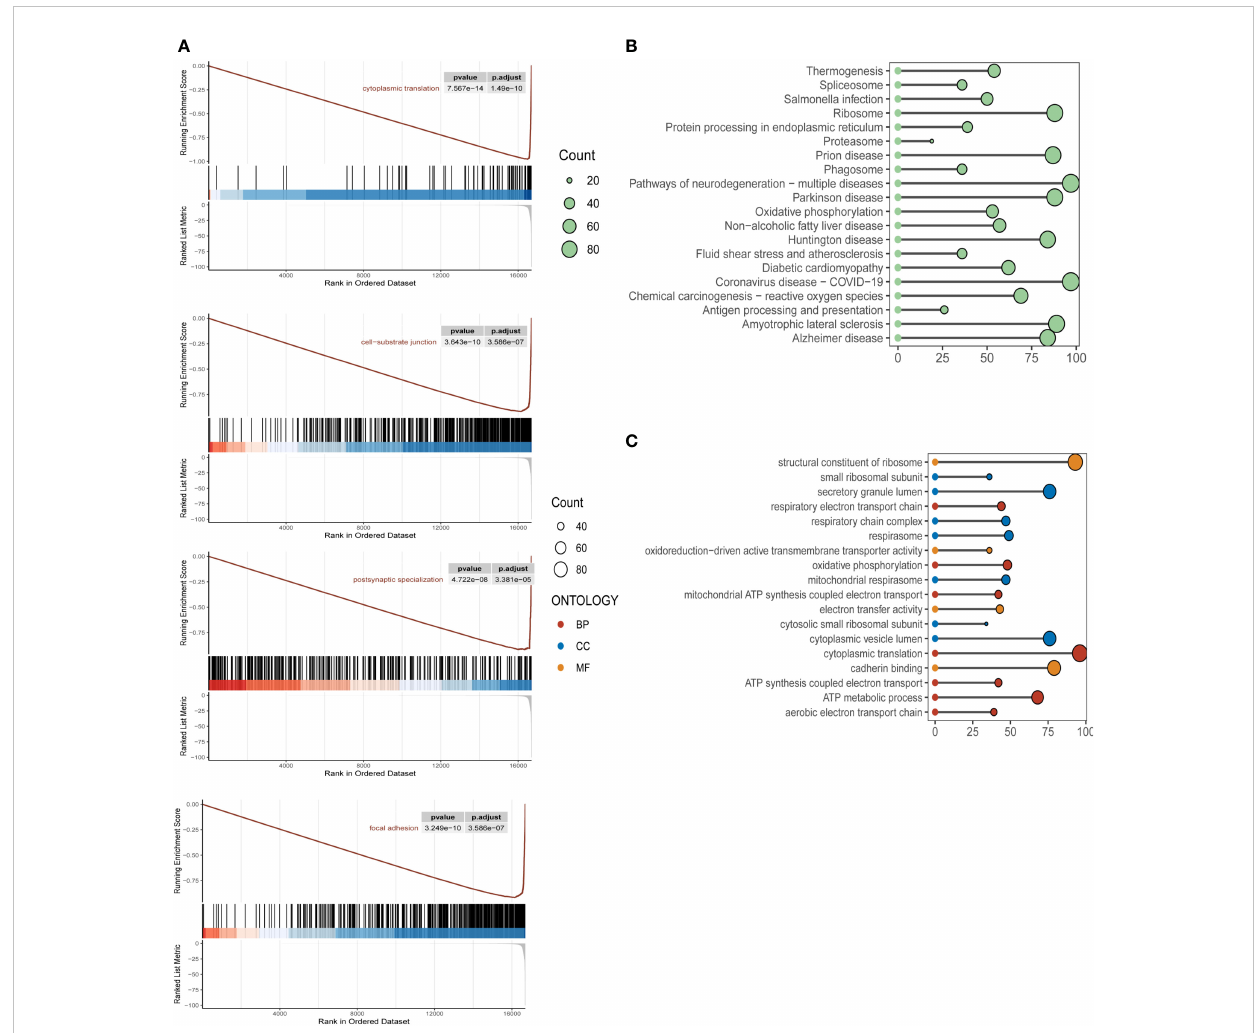
FIGURE 2 Biological functional enrichment analysis of m6A epigenetic in ESCC single cell data (A) . KEGG enrichment pathway analysis of m6A epigenetic- related genes in ESCC patients, mainly enriched in the functional features of cytoplasmic translation, cell-substrate junction, postsynaptic specialization, focal adhesion (B) . GSEA pathway analysis of m6A epigenetically related genes in ESCC patients; (C) GO pathway analysis of m6A epigenetically related genes in ESCC